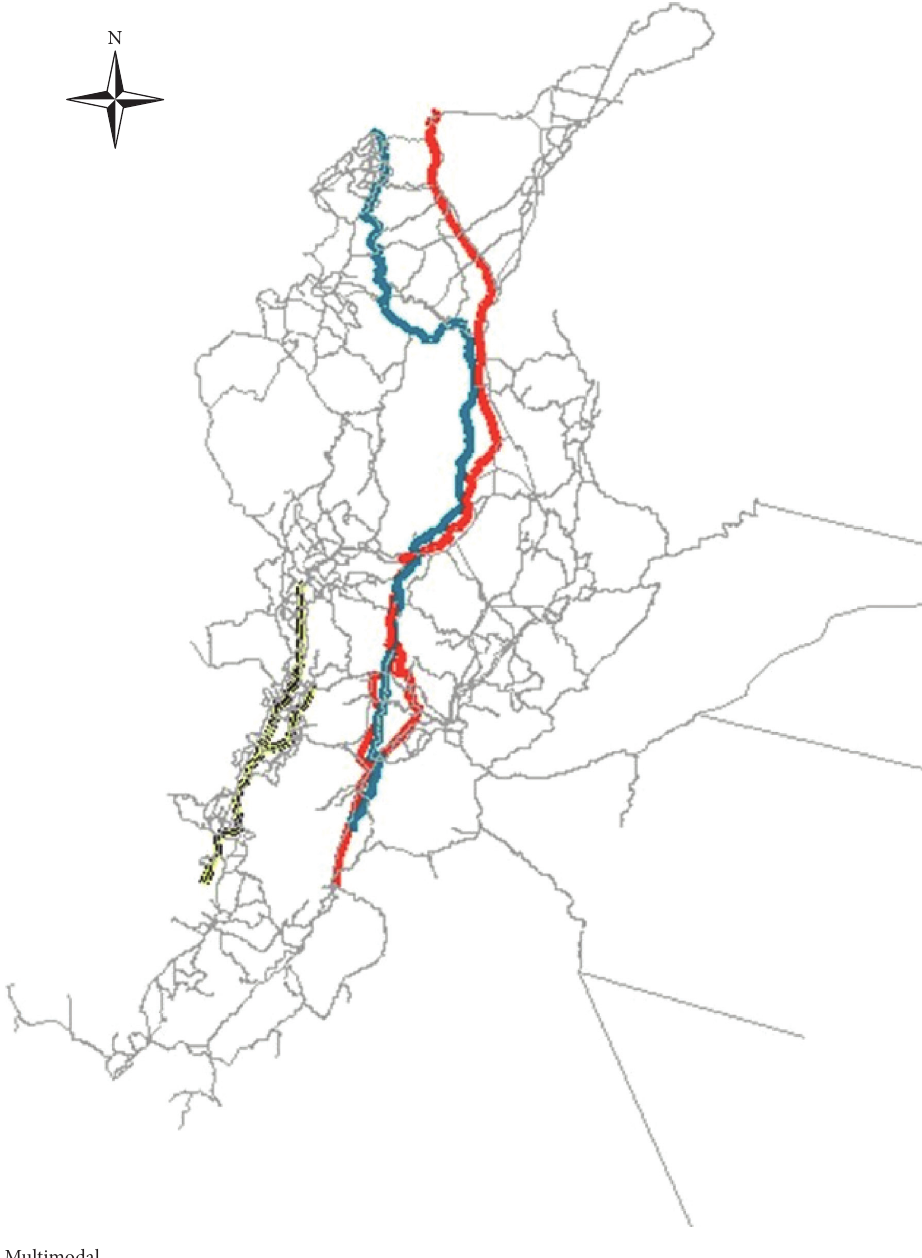
Figure 4: Railway and waterway infrastructure projects